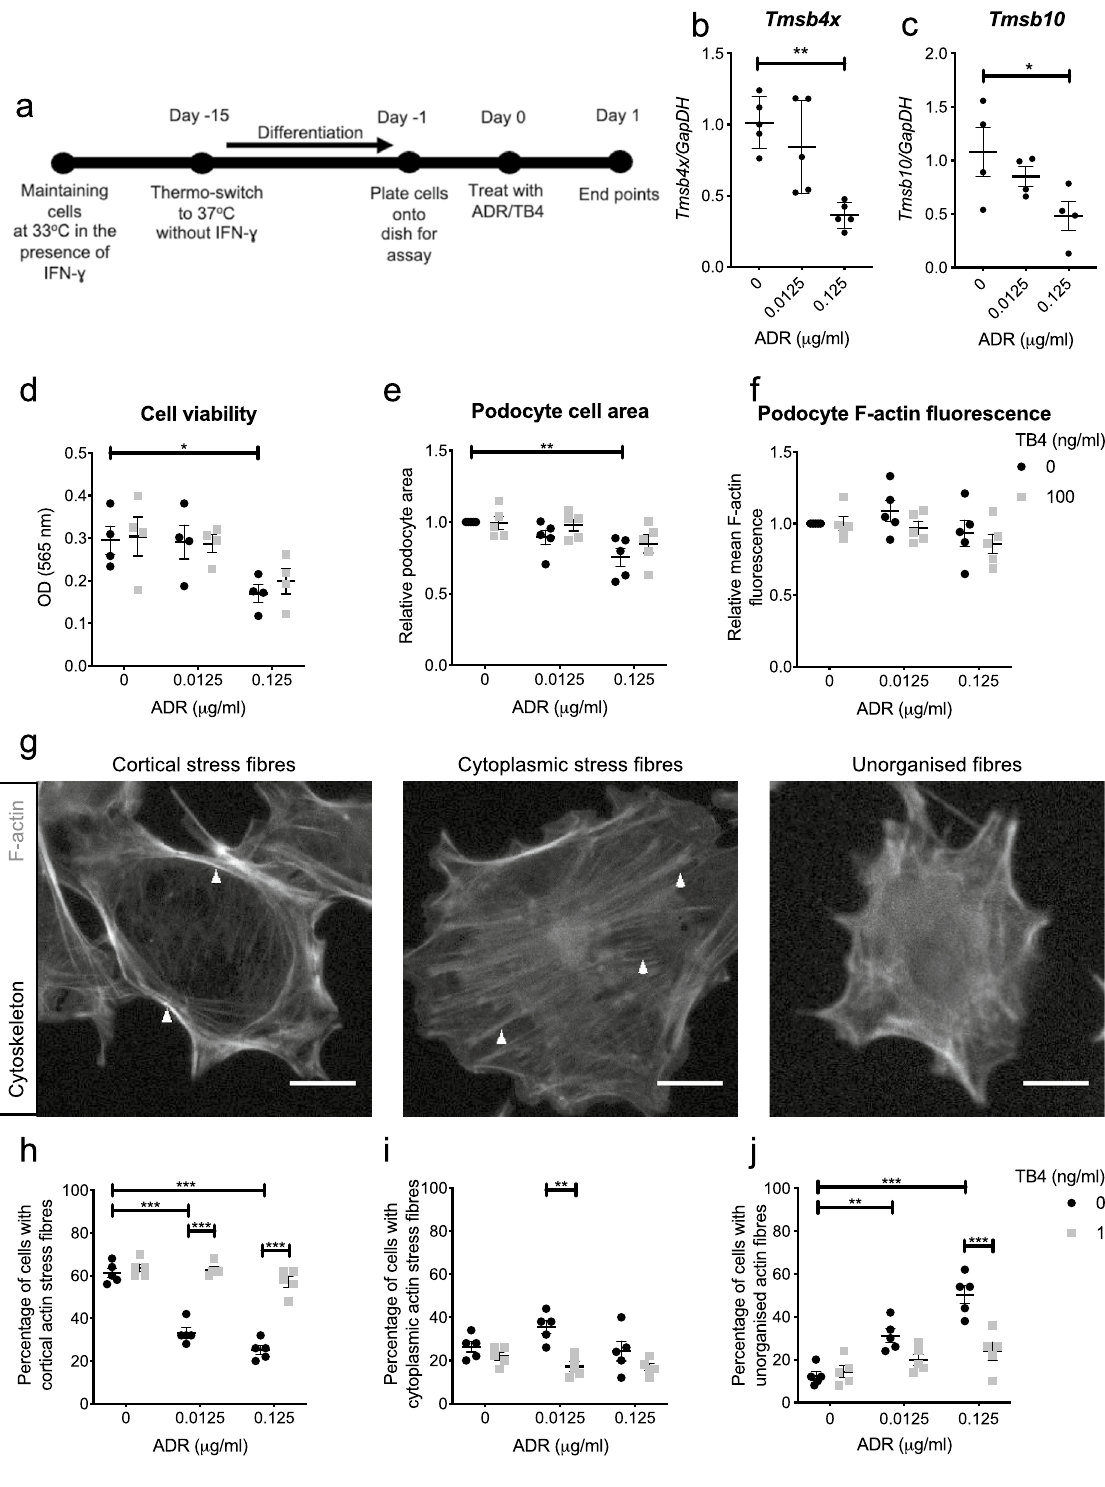
Figure 5. Effect of exogenous TB4 on ADR-injured podocytes in vitro. (a) Conditionally immortalised mouse podocytes were treated with RPMI-1640/ADR/TB4 and analysed after 24 h. Expression of podocyte Tmsb4x (b) and Tmsb10 (c) mRNA after ADR/TB4 treatment ( n = 5 independent experiments; one-way ANOVA with Tukey post hoc test). Effect of ADR/TB4 on (d) cell viability ( n = 4 independent experiments; two-way ANOVA with Tukey post hoc test). Effect of ADR/TB4 on (e) podocyte cell area and (f) podocyte mean F-actin fluorescence ( n = 5 independent experiments with 50 cells analysed per condition, per experiment; two-way ANOVA with Tukey post hoc test). (g) Representative images of podocytes stained with Acti-Stain™ 488 Phalloidin displaying cortical actin stress fibres, cytoplasmic stress fibres and unorganised actin fibres. Scale bar = 10 μm. Percentage of podocytes displaying (h) cortical actin stress fibres, (i) cytoplasmic stress fibres and (j) unorganised stress fibres ( n = 5 independent experiments with 50 cells analysed per condition, per experiment; two-way ANOVA with Tukey post hoc test). Data are presented as mean ± SEM; * P ≤ 0.05, ** P ≤ 0.01 and *** P ≤ 0.001. TB4, Tmsb4x, thymosin β4; Tmsb10, thymosin β10; ADR, Adriamycin; IFN- ɣ , interferon-gamma; OD, optical density; GapDH, Glyceraldehyde 3-phosphate dehydrogenase; MTT,